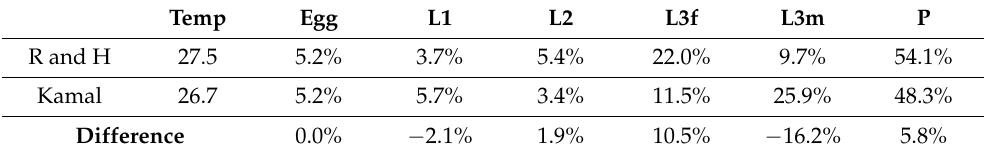
Table 5. Comparison between Kamal [7] and Roe and Higley of Lucilia sericata as percent in stage.